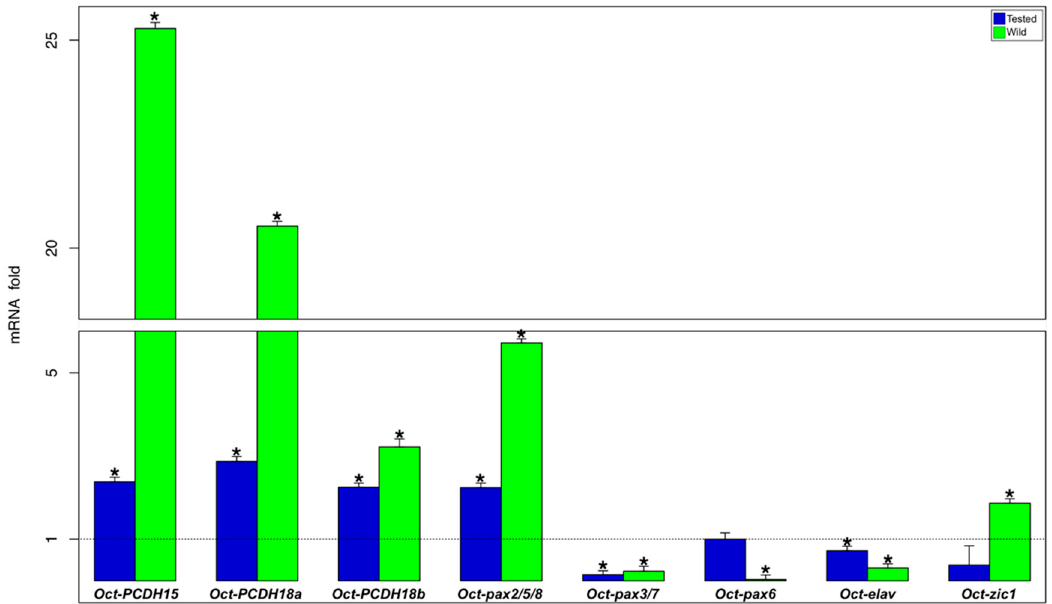
Figure 3. Gene expression analysis in the supraesophageal mass. Relative mRNA fold change in gene expression in tested (blue) and wild (green) animal groups are compared to the control (N=6/group; dot line set y = 1). * asterisk indicates that the difference vs. control group is statistically significant (Wilcoxon-test, p < 0.05). Error bars represent the SEM.